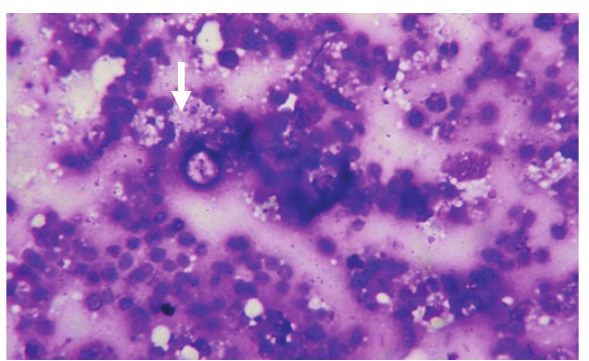
FIGURE 4: Fine needle aspiration cytology specimen from the fundus showing foamy macrophages (arrow) and polymorphs on May–Grunwald–Giemsa stain, consistent with the diagnosis of xanthogranulomatous